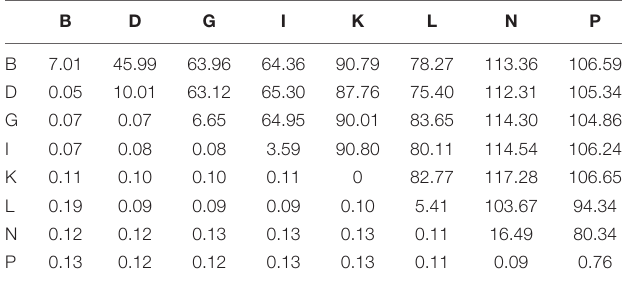
TABLE 1 | Distribution of haplogroups [named according to Achilli et al. (2012)] among Holstein mares from the dataset and estimates of the mitochondrial diversity within haplogroups.